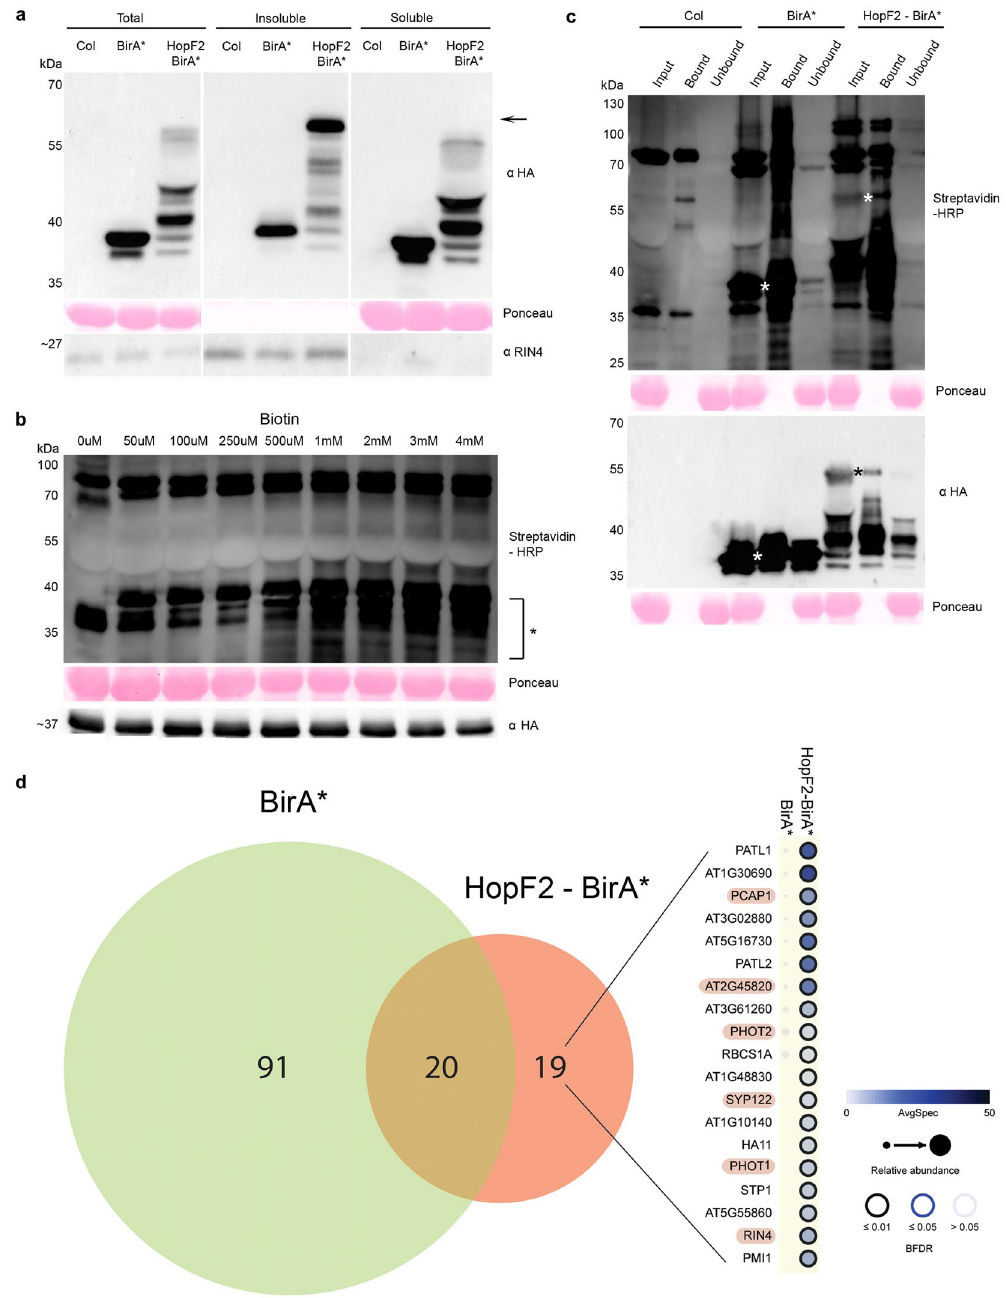
Figure 1. Proximity dependent biotin identification (BioID) in Arabidopsis. ( a ) Immunoblot of total, insoluble (membrane) and soluble extracts from Col-0 and transgenic plants expressing BirA * (~35 kDa) or HopF2- BirA * (~60 kDa; marked by an arrow) using HA antibody. Extracts were probed with RIN4 antibody as a fractionation control. Ponceau staining is presented as a loading control. Since RuBisCO was not found in the insoluble fraction, RIN4 also serves as a loading control for insoluble fraction. (Note that proteins from the insoluble samples migrated slower on the SDS-PAGE giving them an apparent higher molecular weight, which may be due to differences in sample buffer composition after resuspension of the insoluble pellet (see Methods)). (Note that the images were cropped to show relevant samples and uncropped images are available as Supplementary Information). (b) Immunoblot showing biotin labeling efficiency across concentration gradient (0 μ M–4 mM) of exogenous biotin applied to BirA * plants. Biotinylated proteins from total extracts were detected using HRP-conjugated streptavidin. Saturation is most obvious in lower molecular bands ( < 35 kDa) indicated with an asterisk. HA antibody was used to detect baits in all extracts. (Note that the images were cropped to show relevant samples and uncropped images are available as Supplementary Information). (c) Streptavidin affinity purification of total leaf extracts from Col-0 (parental ecotype), and transgenic plants stably expressing BirA * or HopF2-BirA * , infiltrated with 2 mM exogenous biotin (see Methods). Total protein extract (Input), biotinylated proteins pulled down by streptavidin affinity purification (Bound) and proteins